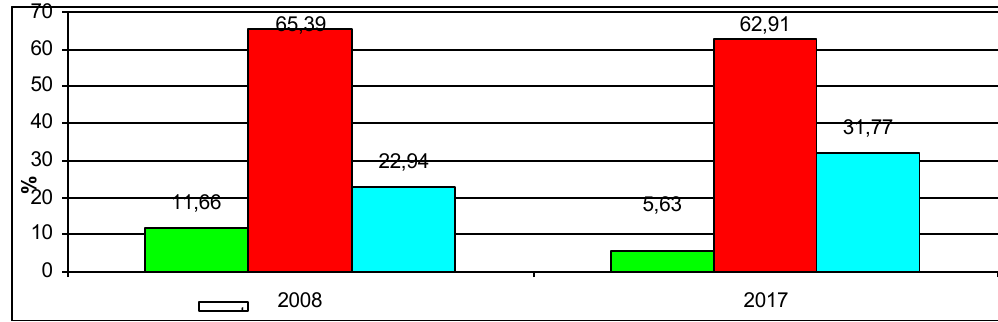
Fig. 1. The distribution of young men by somatotypes in 2008 and 2017 (in %) Table 1. Motor characteristics of young men with different body types, examined in 2008 and 2017. (M ±